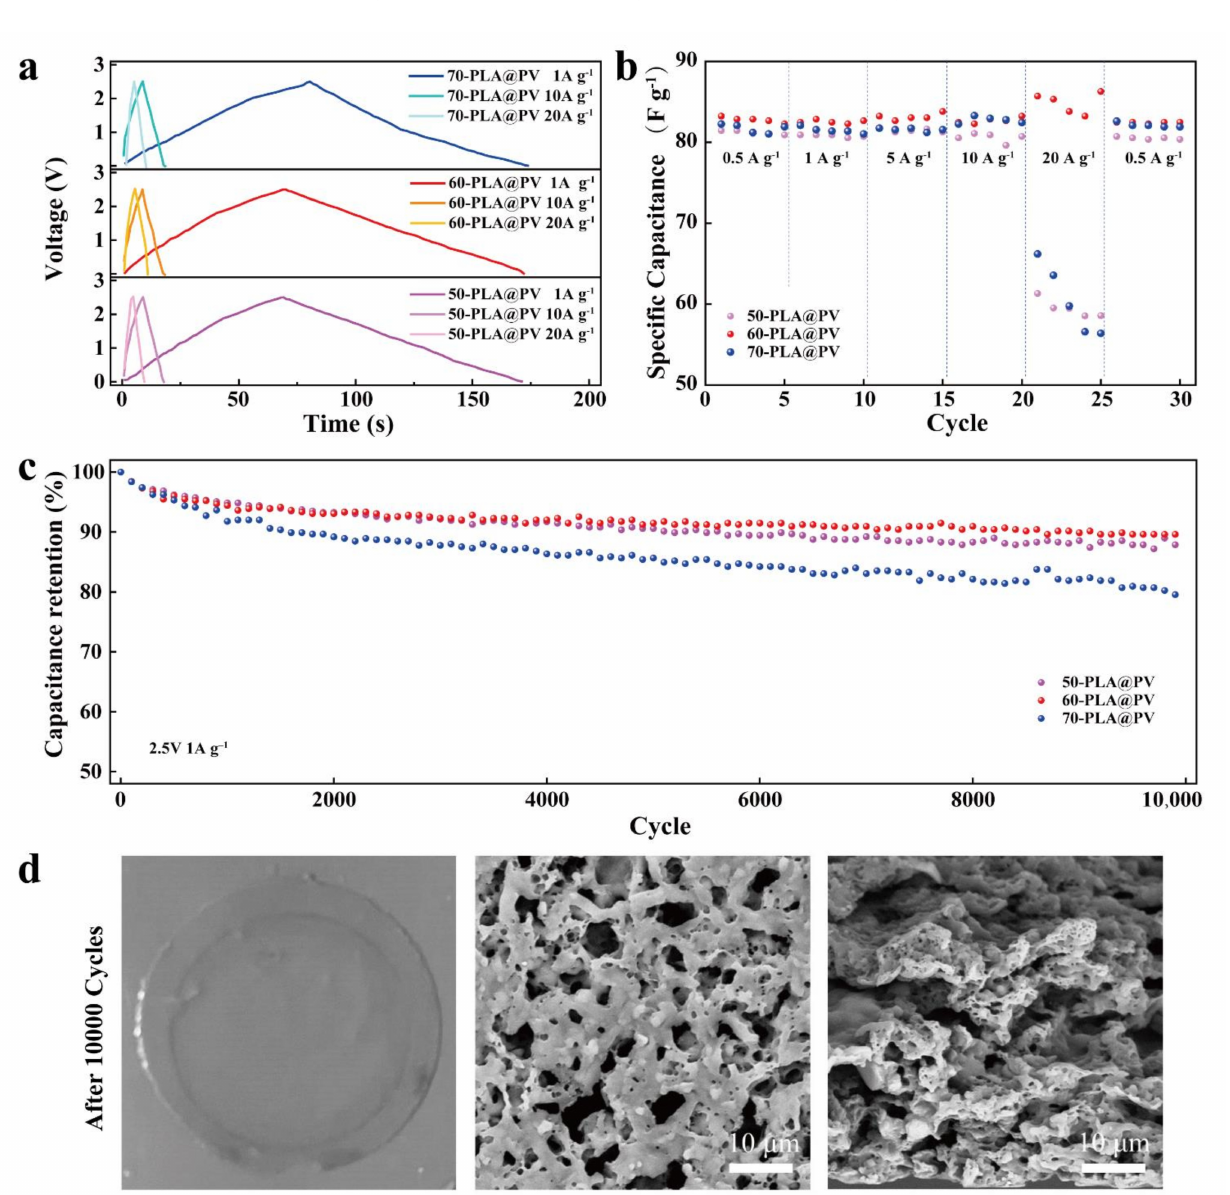
Figure 5. Electrochemical performance of coin type SCs under 2.5 V: ( a ) Galvanostatic charge/discharge profile. ( b ) Specific capacitance plots at various current densities. ( c ) Cycling performance at 1 A g − 1 for 10,000 cycles. ( d ) Digital and SEM graphs (surface and cross section) of the GPE after 10,000